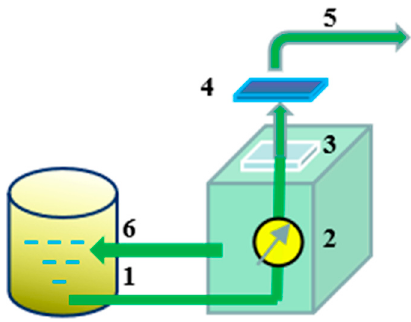
Figure 2. Membrane filtration system: (1) Feed inlet; (2) Pump assembly; (3) Membrane carrier; (4) Membrane; (5) Effluent; (6) Circulating effluent.